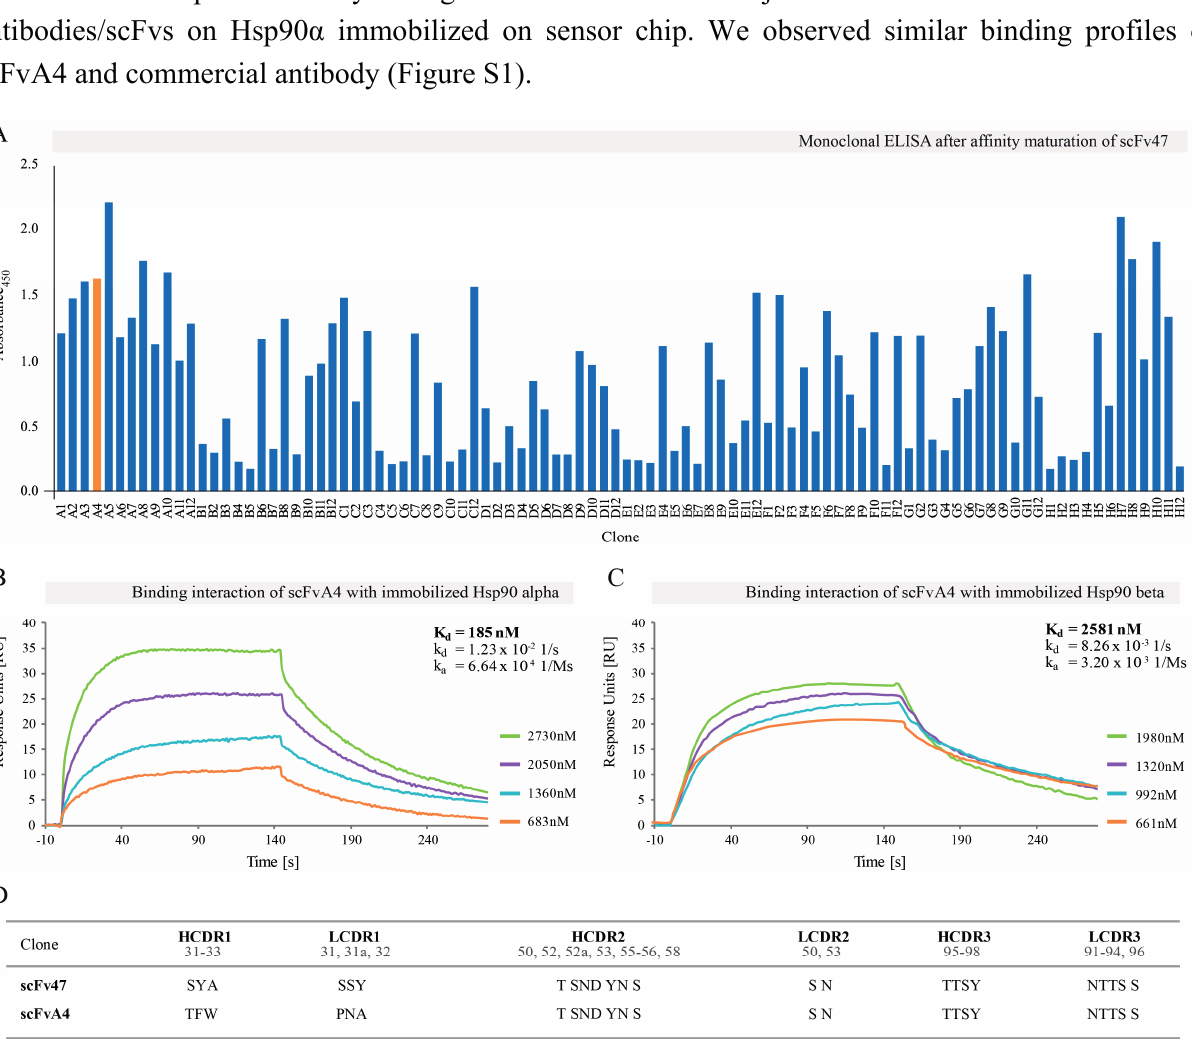
Figure 2. The results of affinity maturation for scFv47 clone. ( A ) Monoclonal ELISA for scFv clones selected after the second round of panning against Hsp90 α . Of all clones, 35 were selected for further analysis by SPR on Biacore ® 3000. The best clone scFvA4 is highlighted with orange; ( B , C ) Binding curves for scFvA4 clone against Hsp90 α and Hsp90 β , respectively. Varied concentrations of purified protein were injected on two CM5 sensor chips immobilized with Hsp90 isoforms. The BIAevaluation software was used for calculations of kinetic constants; ( D ) The amino acids selected at CDR1, CDR2 and CDR3 of parental and affinity matured